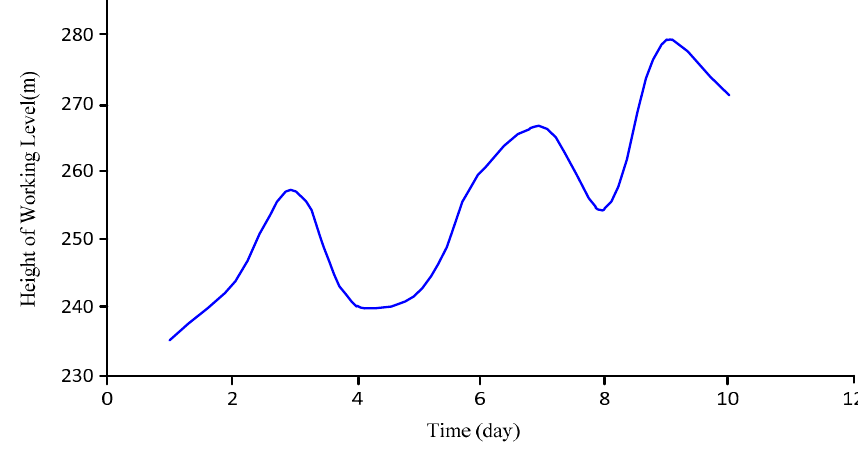
Figure 16. On-site data during a continuous period.